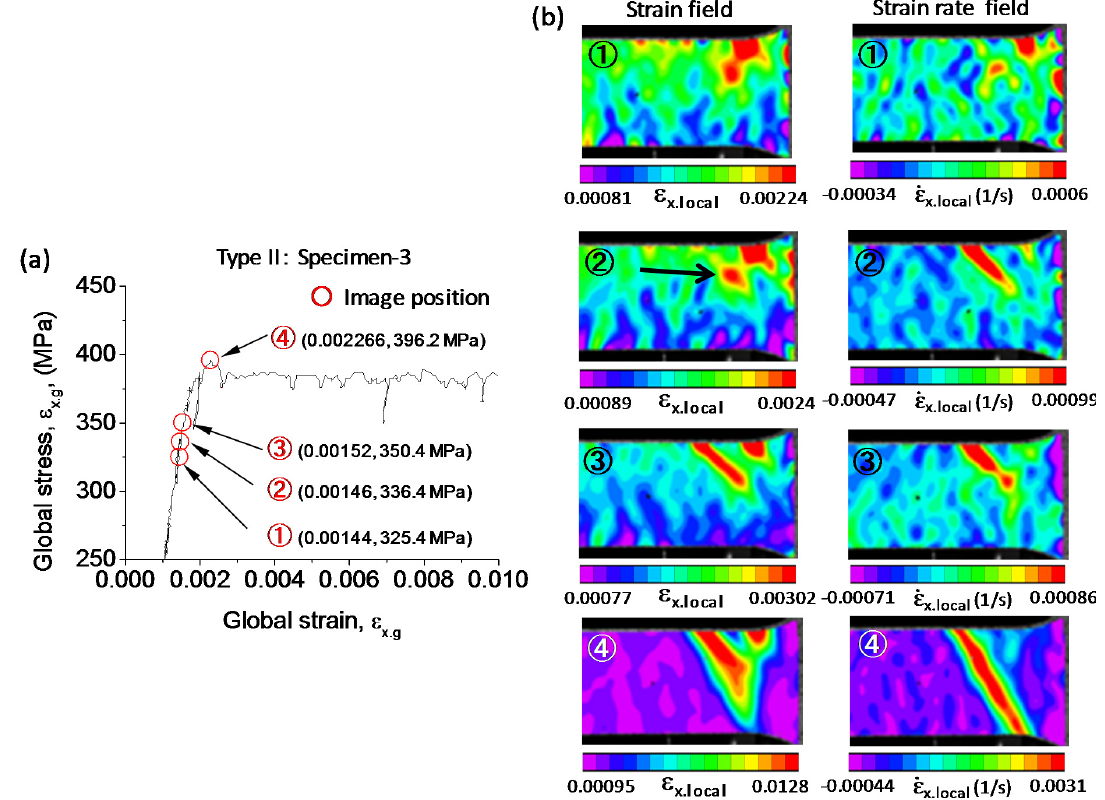
Figure 8. ( a ) Image position in the stress-strain curve. ( b ) Strain field and strain rate field of image 1 (cid:79) to image 4 (cid:79) . 1 (cid:79) Global stress level 0.821 σ up.ys.ob , 2 (cid:79) global stress level 0.849 σ up.ys.ob , 3 (cid:79) global stress level 0.884 σ up.ys.ob , and 4 (cid:79) global stress level σ up.ys.ob . Time interval: 1 (cid:79) to 2 (cid:79) , 0.5 s, 2 (cid:79) to 3 (cid:79) , 0.5 s, 3 (cid:79) to 4 (cid:79) , 12.5 s. DIC parameters: subset size, 9 pixels × 9 pixels (246 µ m × 246 µ m), step, 5 pixels (137 µ